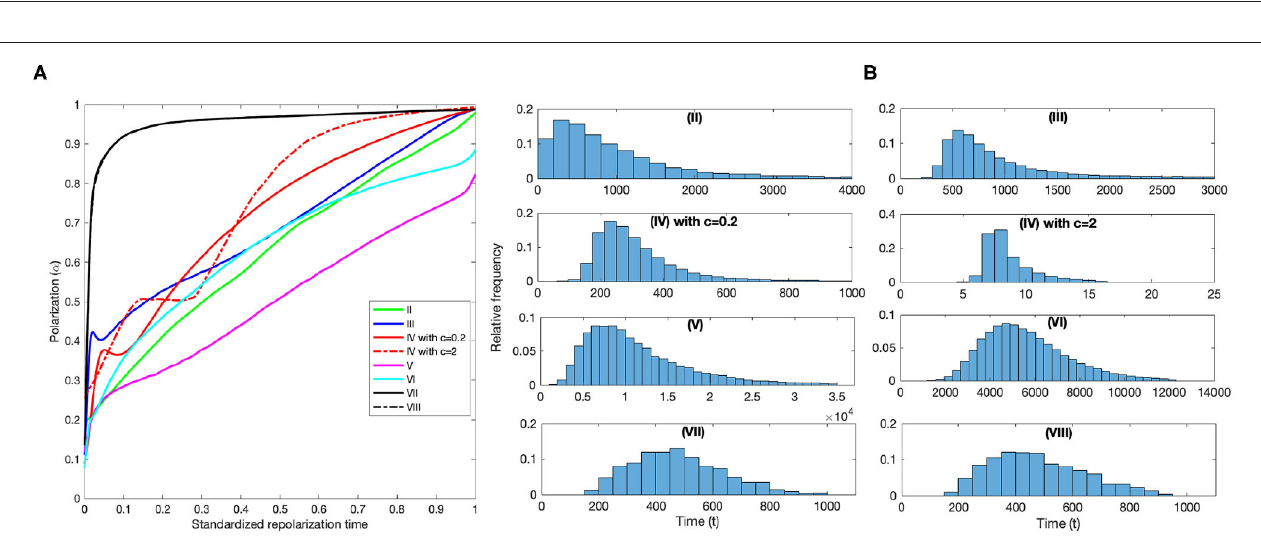
FIGURE 4 | Polarization processes for the eight models. (A) Median polarization curves for the models focused on those that generate polarized groups at a fast or intermediate rate (III,IV,VII,VIII). (B) Median polarization curves for the models focused on the three models that polarize the group more slowly (II,V,VI). (C) Relative frequency distributions of the time to polarization for each model.